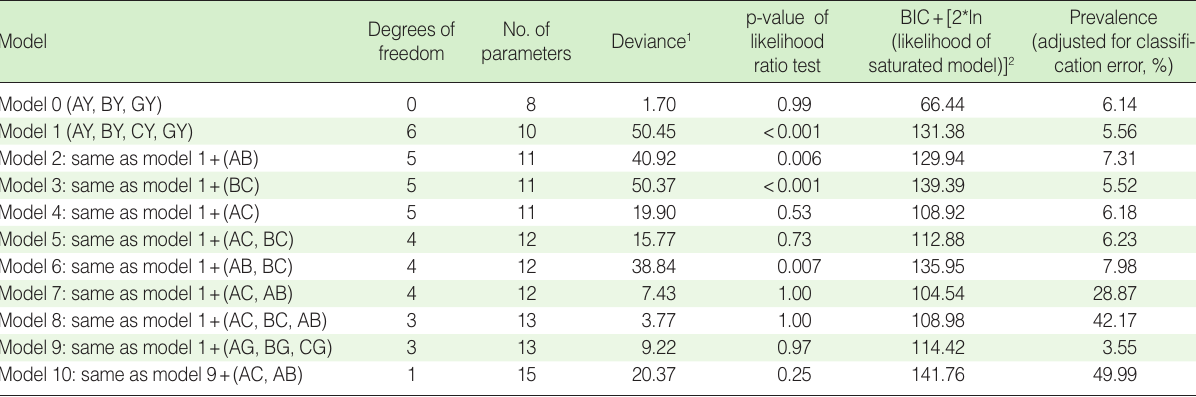
Table 2. Characteristics of alternative latent class log-linear models applied to the IranMHS data regarding illicit drug use